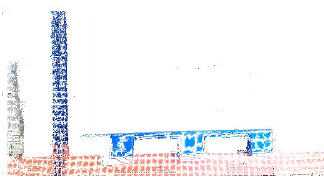
Figure 15. Pass-through filtering.